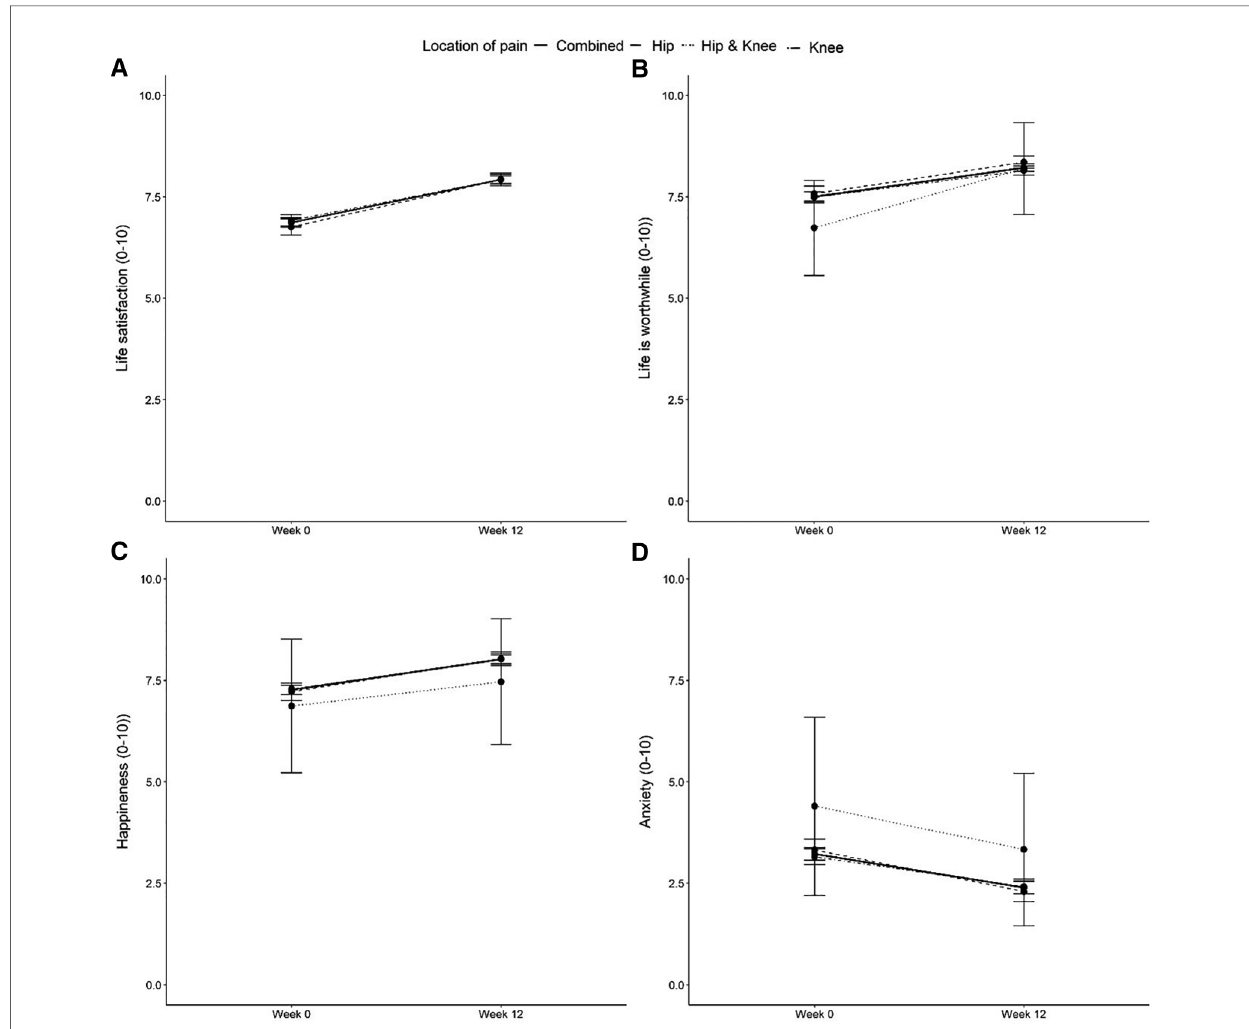
FIGURE 2 Baseline and Week 12 values for ONS-4 self-reported life satisfaction ( A ), life being worthwhile ( B ), happiness ( C ) and anxiety scores ( D ). Values are presented as mean (95% CI). Lower scores indicate worse health for ONS4 life satisfaction, life is worthwhile and happiness scores. Higher scores indicate worse health for ONS4 anxiety. Differences between time points were analysed using paired t-tests. For all groups, all p <0.001. Combined: n =1278; Hip scores: n =413; Knee scores: n =850; Hip & Knee: n